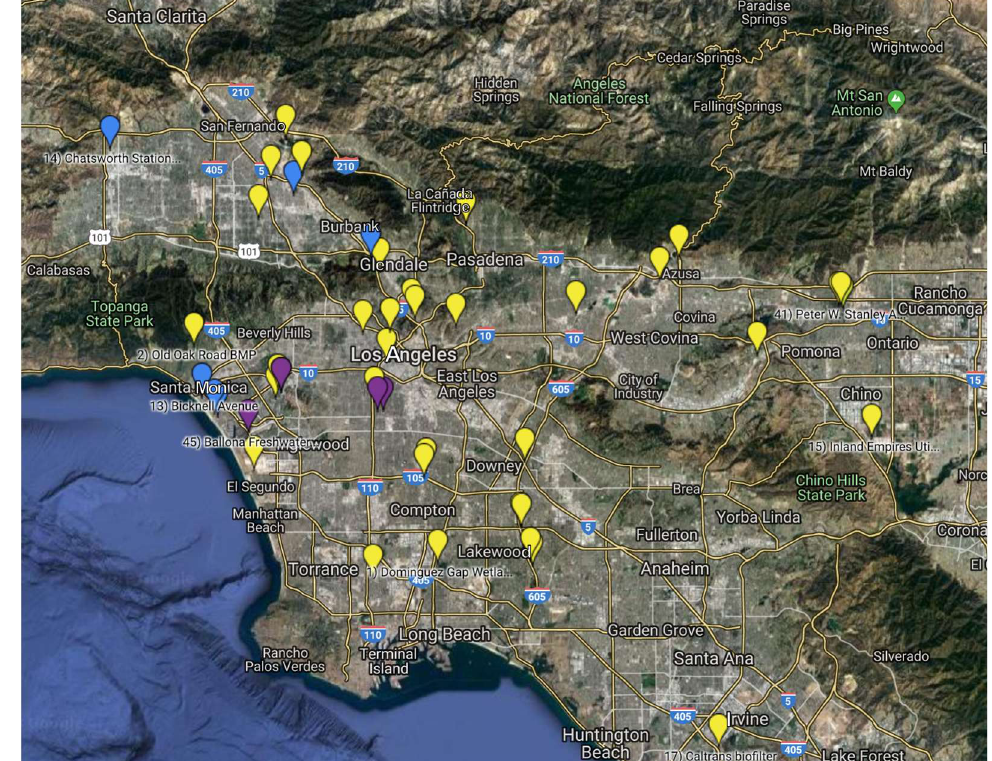
Figure 2. Location of natural stormwater treatment systems in Los Angeles County [27]. Blue indicates sites visited in 2015. Purple indicates sites visited in 2016. View the interactive Google map here: https://goo.gl/76sswN (accessed on 31 January